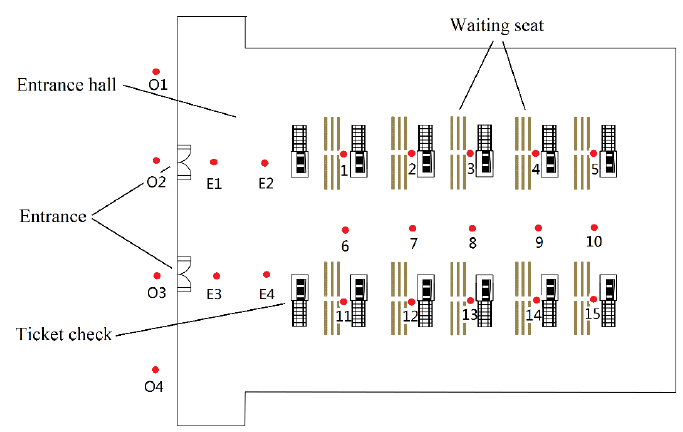
Figure 7. Layout of measuring points for B3.